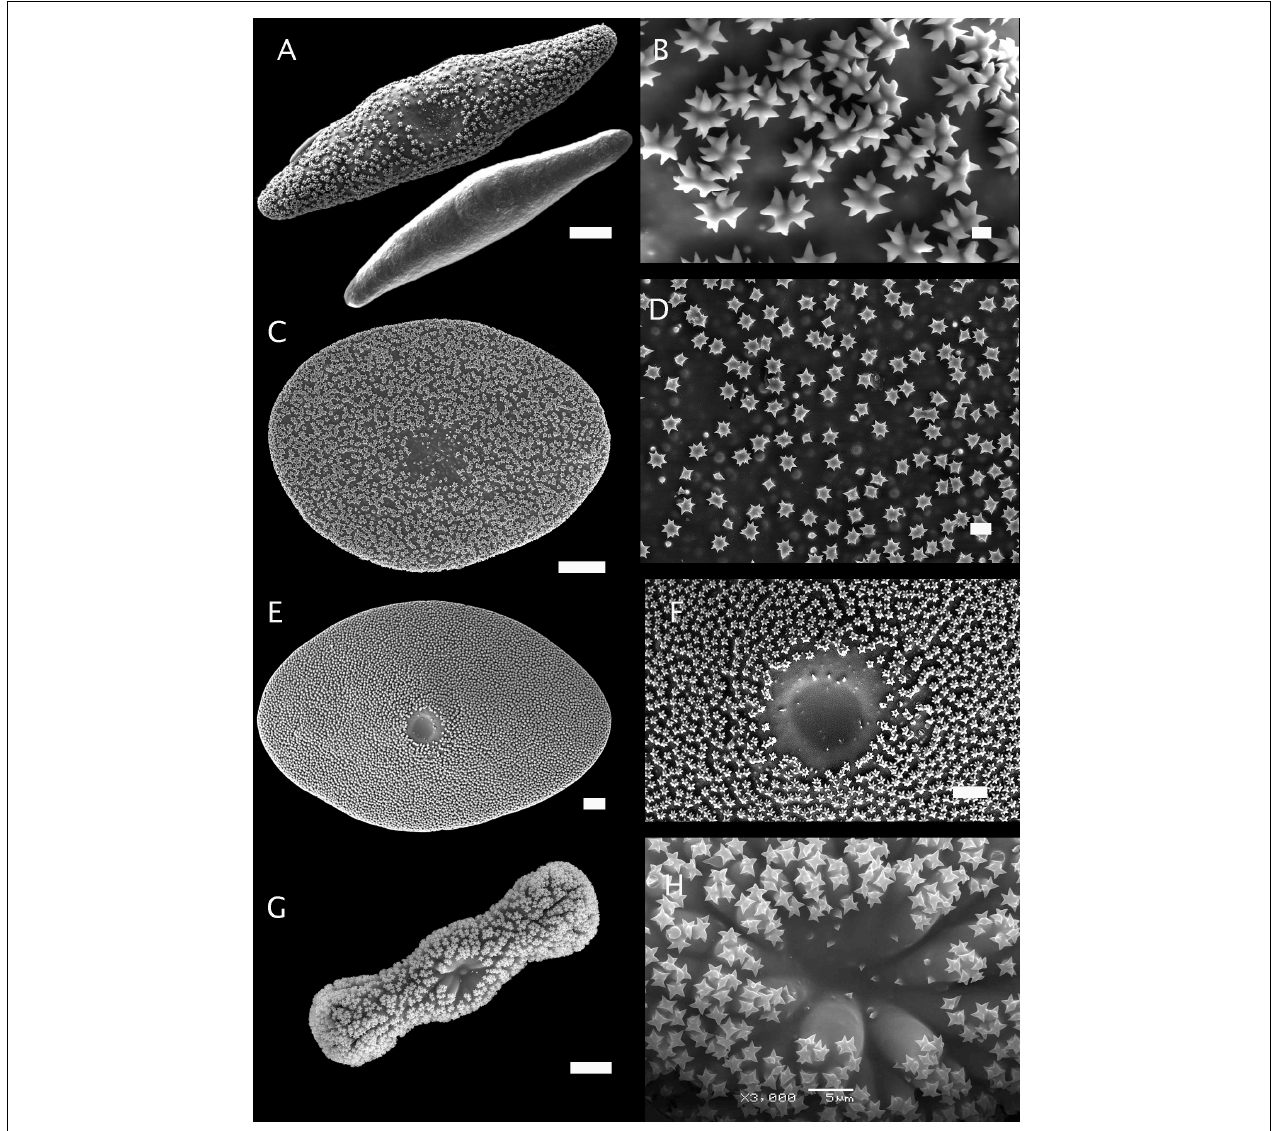
FIGURE 6 | Morphology of aspidasters from Erylus and Penares . (A,B) Aspidaster of Erylus formosus (Bocas del Toro, Panama, ZMBN 81644) and its young smooth stage before the growth of rosettes. Scale A: 20 µ m. Scale B. 1 µ m. (C,D) Aspidaster of Penares euastrum , previously called Erylus euastrum